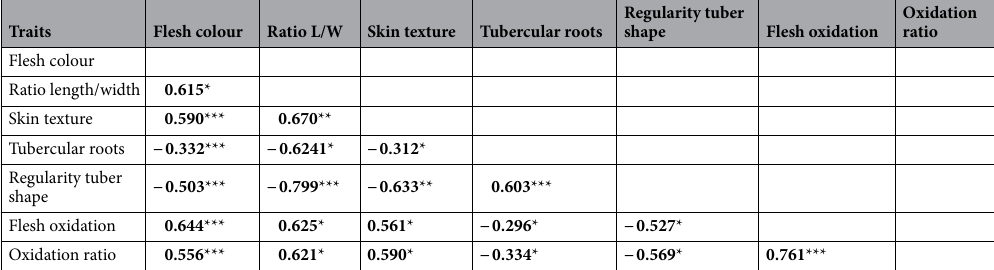
Table 4. Correlation coefficients (Spearman’s r values) computed mean values over years between ratio length/ width, regularity of tuber shape, skin texture, tubercular roots, flesh colour, flesh oxidation and oxidation ratio of mapping population B (74F × 14M). Significant values are in [bold]. n.s: not significant. *Significant at p < 0.05, **significant at p < 0.01 ***significant at p <